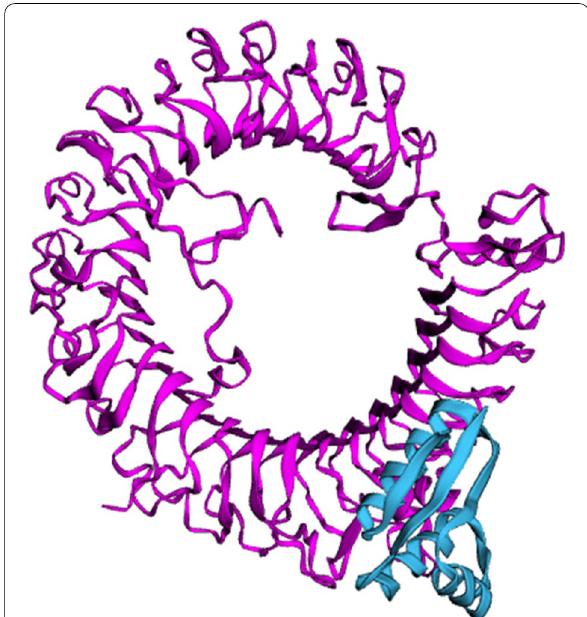
Fig. 7 TLR-8 vaccine interaction predicted by HawkDock server. The vaccine is represented in blue and TLR-8 in